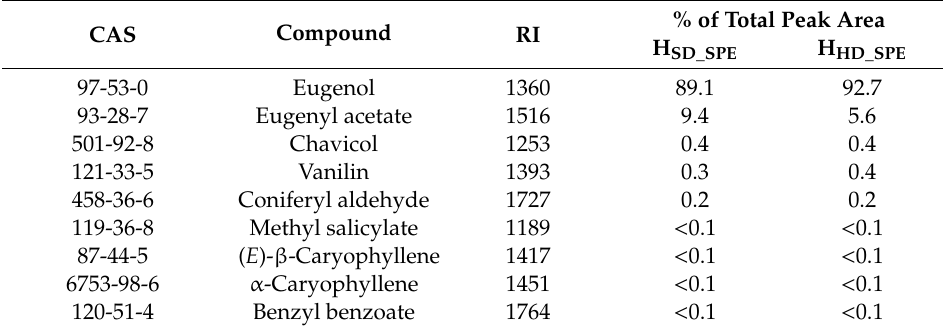
Table 5. List of compounds identified in hydrolate extracts from Syzygium aromaticum